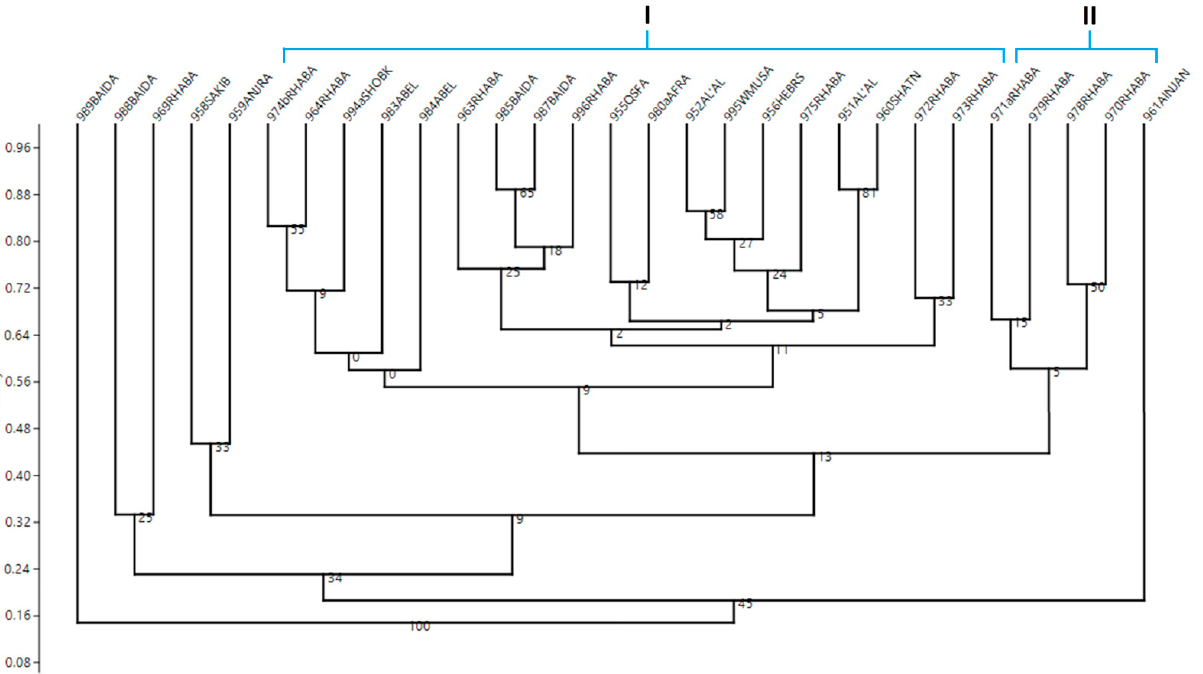
Figure 3. Dendrograms generated using unweighted pair group method with arithmetic average (UPGMA) analysis, showing relationships between 29 tomato landraces (Accession number and collection site), using SSR data based on Jaccard genetic similarity index. Bootstrap support value is given above each branch.